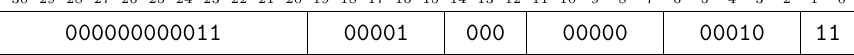
Figure 1: Encoding of a RISC-V fenl.fence